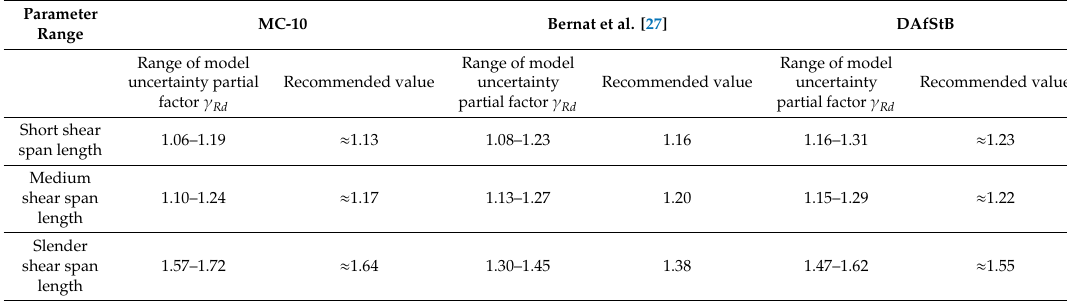
Table 6. Model uncertainty global partial factor γ Rd for parameter